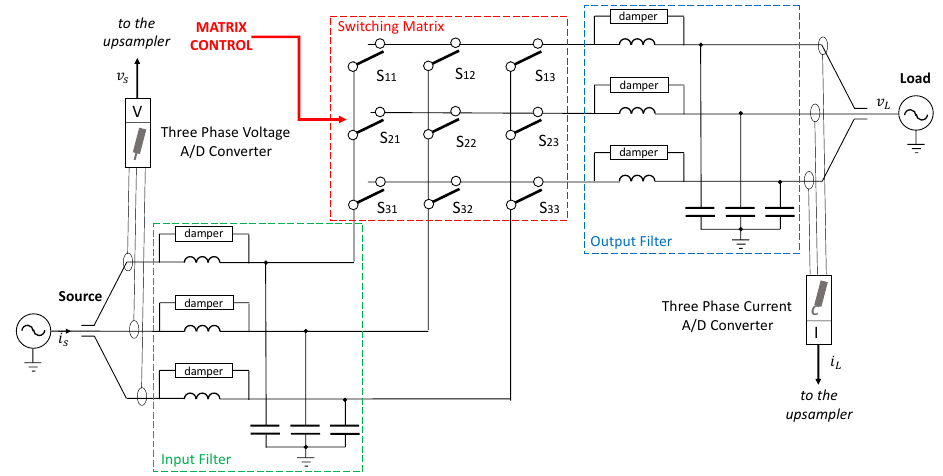
Figure 1. Analog part of the converter, comprising the direct matrix, the input and output filters, and the voltage and current analog-to-digital (AD)